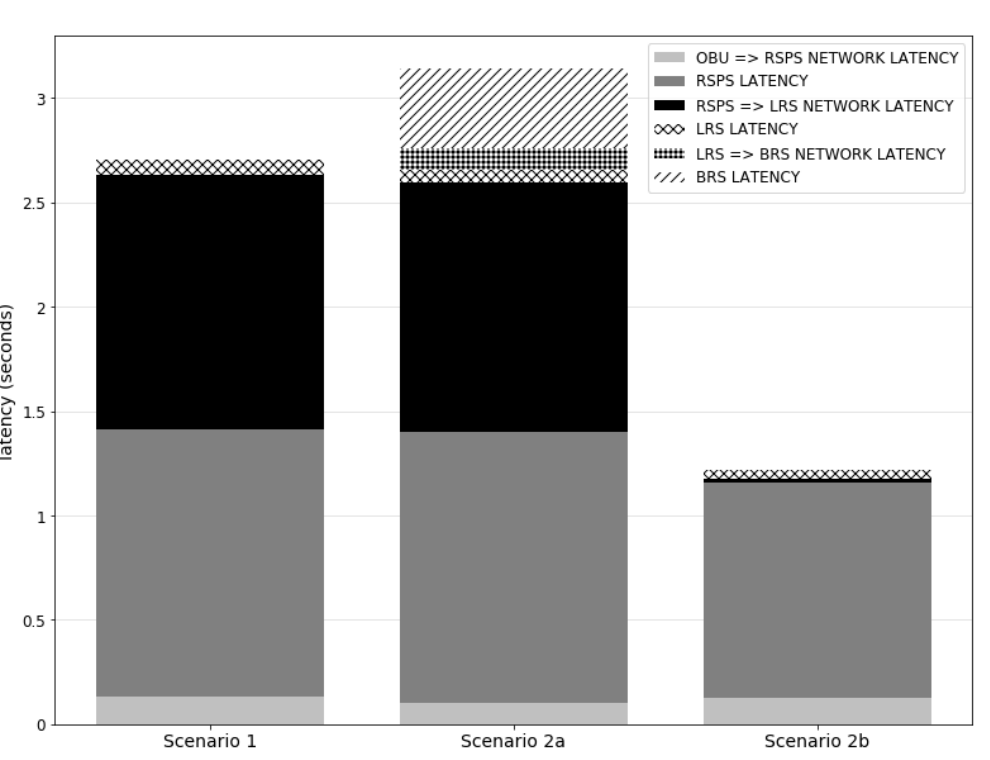
Figure 8. Bar plot showing the average total system latency of three types of observations, over all scenario runs: the observation in scenario 1 causing a WarnNurseAction handled locally, the observation in scenario 2a leading to a CallNurseAction handled by the back-end, and another observation in scenario 2b that causes the creation of another WarnNurseAction . For each situation, the different network and component latencies that sum up to the total system latency are indicated by the stacked